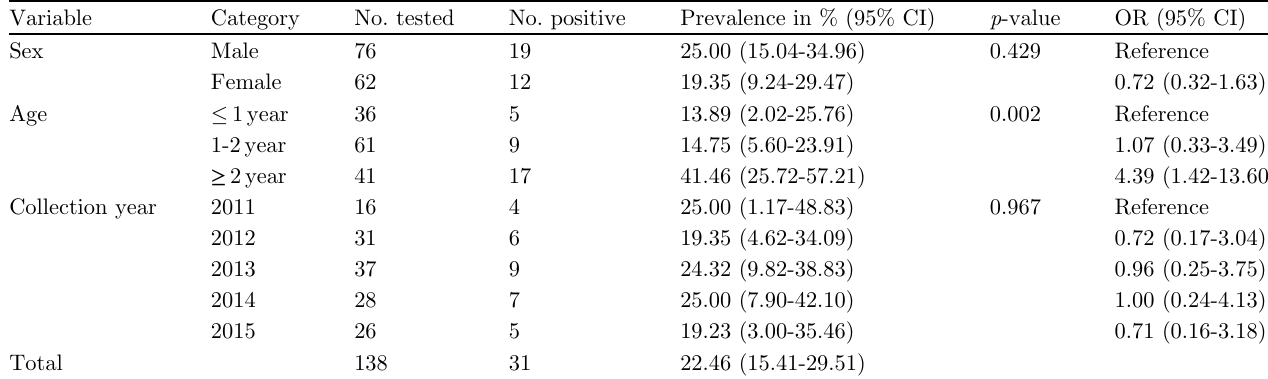
Table 1. Seroprevalence of Toxoplasma gondii in mou fl on by sex, age and collection year.